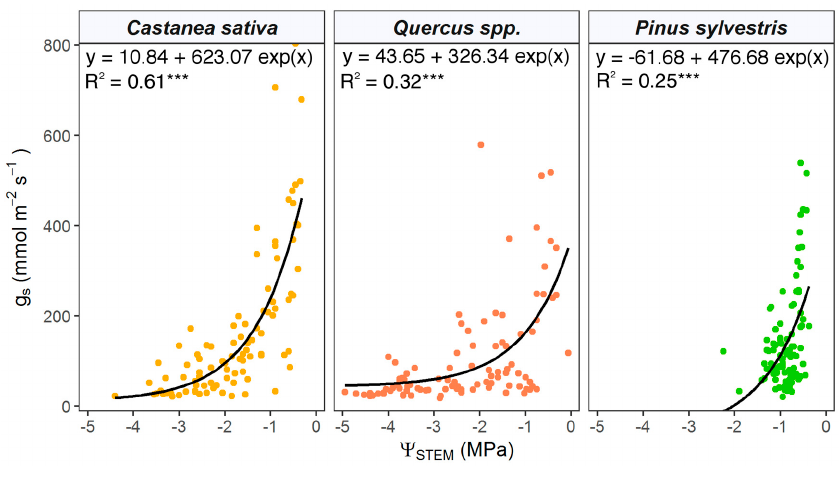
Figure 5. Relationships and their exponential fit between stomatal conductance g s and stem water potential Ψ STEM in 2015. *** p < 0.001.